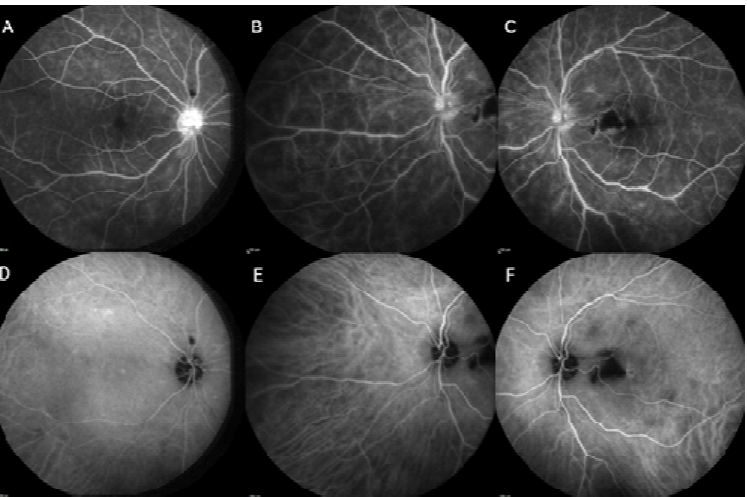
Figure 5. Fluorescein angiogram of both eyes of case 2 patient. Fluorescein angiogram of the right eye ( A ) in late sequence showing diffuse capillaritis and papillitis. Fluorescein angiogram of the left eye ( B , C ) in the same sequence showing central and peripheral capillaritis, papillitis, and a mask effect due to hemorrhage in a retinal necrosis nodule. Indocyanine green (ICG) angiogram in middle sequence of the right eye ( D ) showing no choroidal involvement, and of the left eye ( E , F ) showing predominantly macular spots of hypofluorescence corresponding to